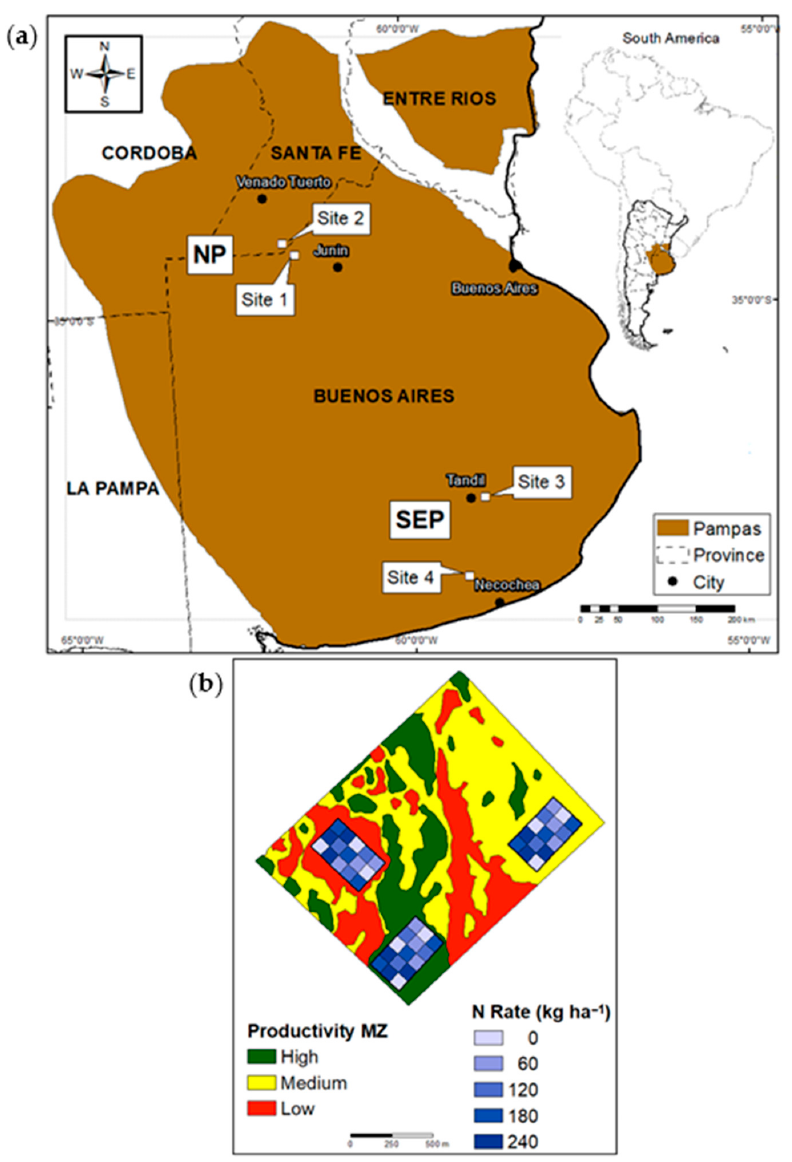
Figure 2. ( a ) Location of the experimental sites in the northern (NP) and south-eastern (SEP) regions of the Argentine Pampas; ( b ) Example of Site 2 map showcasing the implementation of the fertilizer nitrogen (N) rate experiments within different productive management zones (MZ) of the